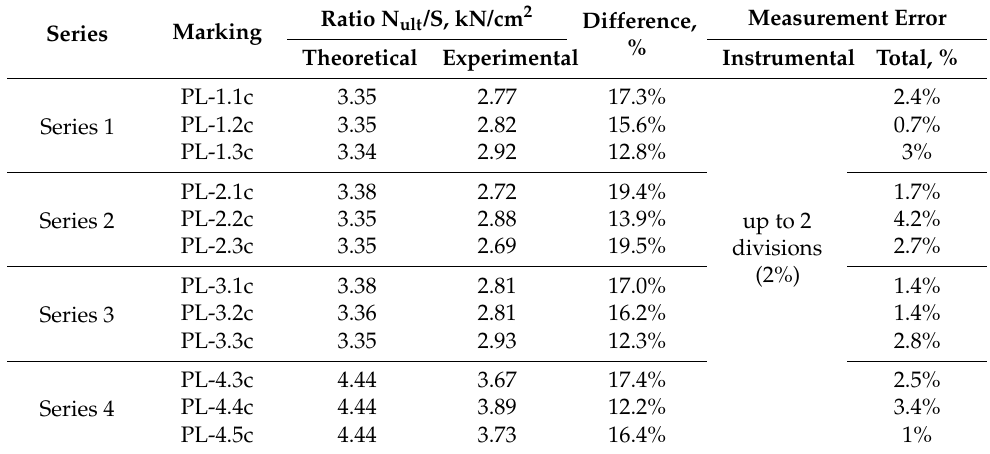
Table 4. Experimental and theoretical values of the ratio N ult /S and measurement